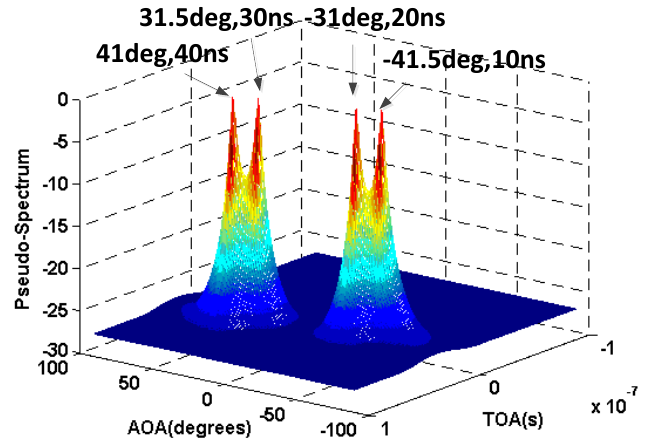
Figure 7. Result of AOA and TOA estimation for the coherent signals with the